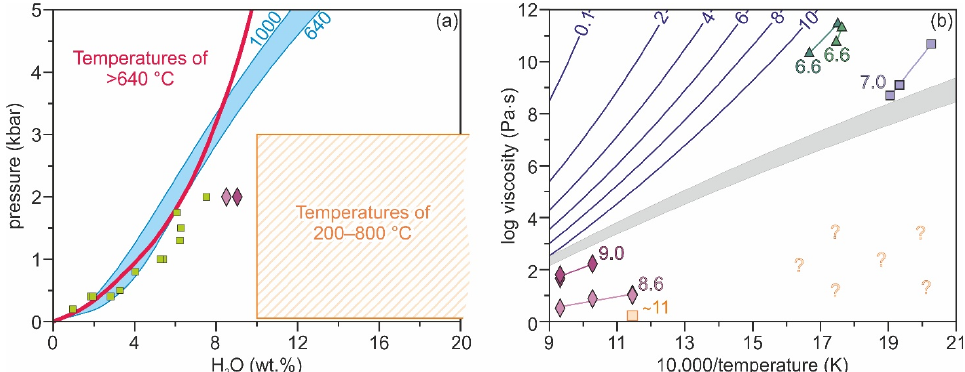
Figure 1. A comparison of hydrosilicate fluids with aluminosilicate melts with respect to possible H 2 O concentrations and viscosities. ( a ) A comparison of H 2 O concentrations reported for hydrosilicate fluids with H 2 O solubility data for aluminosilicate melts. The orange box shows the range of H 2 O contents and synthesis pressures for hydrosilicate fluids [1–15]. The thick red line shows the H 2 O-saturated granite solidus, which has the lowest temperature of ~640 ◦ C [37]. The blue field counters H 2 O solubility curves obtained using the rhyolite option of VolatileCalc [38] for temperatures ranging from 640 to 1000 ◦ C. The green squares show experimental H 2 O solubility data for a metaluminous trachyte [46]. The purple diamonds show H 2 O contents in close-to-saturation peralkaline aluminosilicate melts [44]. ( b ) A comparison of viscosities reported for hydrosilicate fluids with model and experimental data for aluminosilicate melts. The orange square shows the only quantitative viscosity estimate for hydrosilicate fluids with ~11 wt. % of H 2 O [15]. The grey field shows the range of viscosities calculated for the same hydrosilicate fluids using the model of [43] for aluminosilicate melts. Note that this model fails when applied to hydrosilicate fluids. Question marks show the potential range of viscosities at 200–350 ◦ C that could explain the observation of immiscibility phenomena and bubble migration within quartz-hosted synthetic inclusions of hydrosilicate fluids at these temperatures [3,7–12]. This inference is based on the fact that during reheating of melt inclusions in [47] bubbles migrated only in conditions for which the model of [43] yielded viscosities of <10 4 Pa · s. The dark blue lines show viscosities calculated using the model of [43] for a peraluminous andesite composition given in their work and H 2 O concentrations ranging from 0.1 to 10 wt.% as indicated in the plot. Similar viscosities are obtained using the model of [48] for metaluminous granites. The purple diamonds [44] and lilac squares [49] show experimental data for some of the least viscous peralkaline aluminosilicate melts with 7.0, 8.6 and 9.0 wt.% of H 2 O. The green triangles [50] show experimental data for some of the least viscous nearly-peraluminous aluminosilicate melts with an Al/(Li + Na + K) molecular ratio of 1 and 6.6 wt.% of H 2